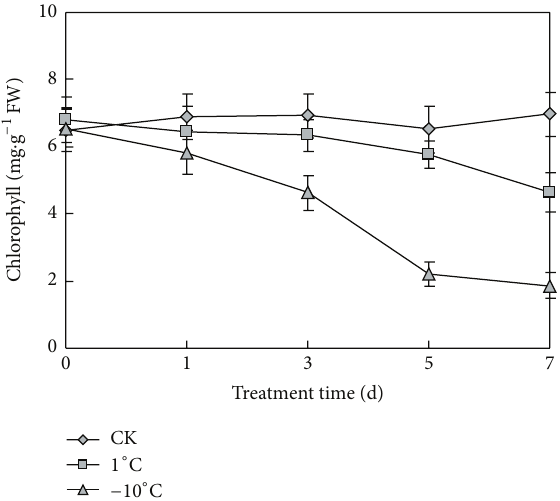
Figure 3: Chlorophyll content of seedling leaves under normal and low temperatures. CK represents normal growth condition. Each value is the average ± standard error ( ± SE) result of three independent